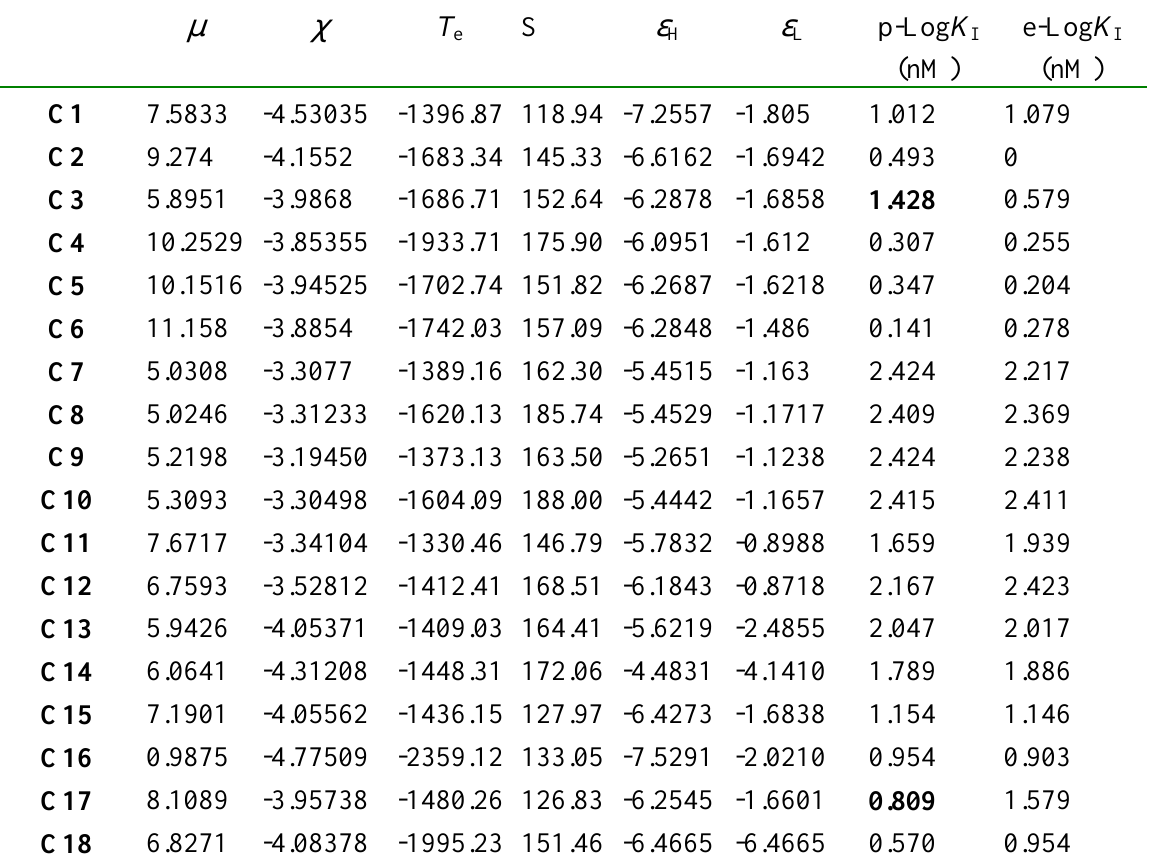
Table 2. Calculated descriptors and predicted and experimental inhibitory activity data of compounds